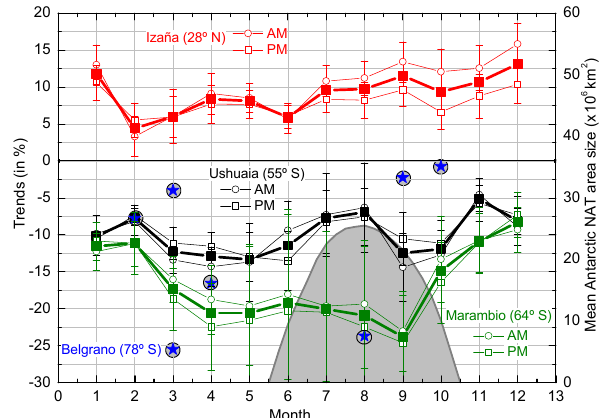
Figure 8. NO 2 decadal trends for the individual months at Izaña, Ushuaia, Marambio and Belgrano. Open circles and open squares represent the AM and PM data, respectively. Solid squares are the monthly means. The Belgrano trends are from the diurnal means. The shadowed area is the mean size of the area of the potential NAT (nitric acid trihydrated) PSCs (right